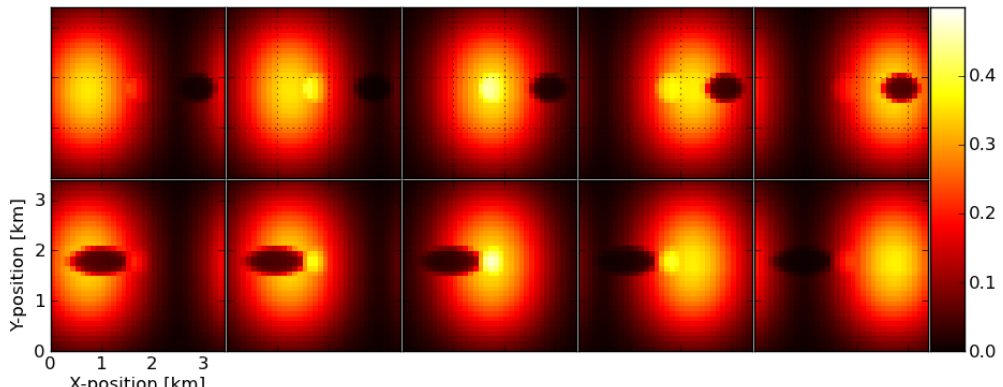
Figure 4. Overhead view of the scene reflectance multiplied by the SRF at positions 0, 5, 10, 15, and 20, for the 0.6km cloud in the O 2 A-band over the soil surface. The SRF moves from left to right over the high spatial resolution grid. The top row shows the SRF sequence for the 35 ◦ solar zenith angle (SZA), and the bottom row shows the sequence for the 60 ◦ SZA. In the top row, the SRF starts at a position where the FOV is primarily filled with a “clear” surface view, to a “cloudy” position, and ends at a “shadowed” position. In the bottom row, the periodic boundary condition used in SHDOM causes the shadow to wrap around to the other side of the high spatial resolution scene for the larger SZA. For this case, the SRF starts in the “shadowed” position, followed by “cloudy” and then “clear”.